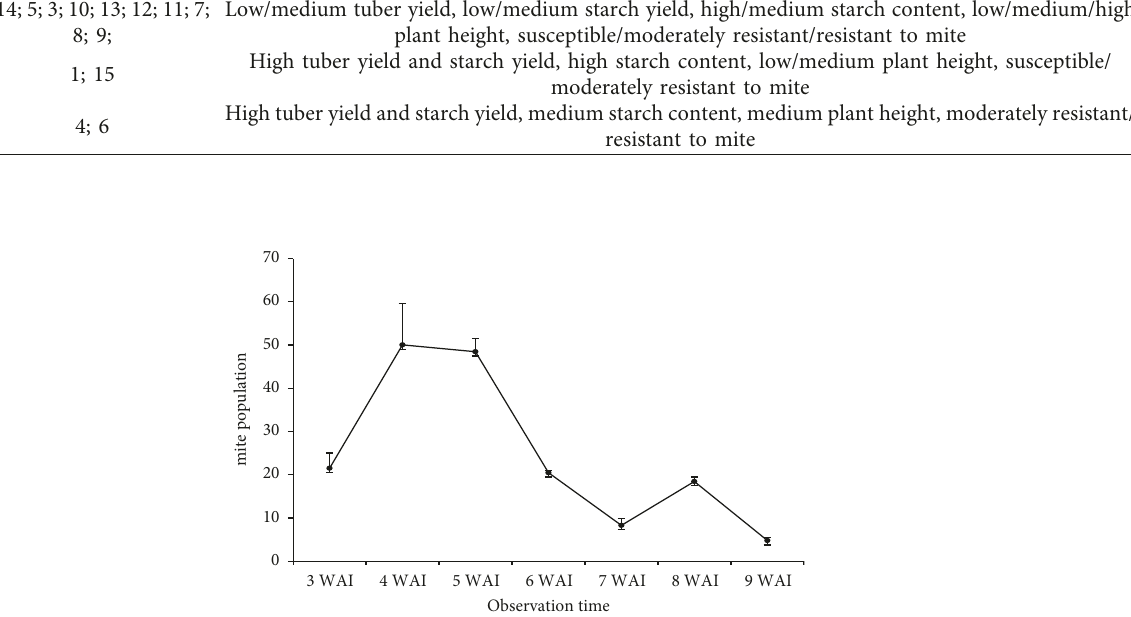
Table 3: Grouping of cassava clones based on plant height in three months, fresh tuber yield in 10 months, starch content, starch yield, intensity of mite attack, harvest index, tuber diameter, and number of tubers/plant. Group Cassava clones Characteristics of group